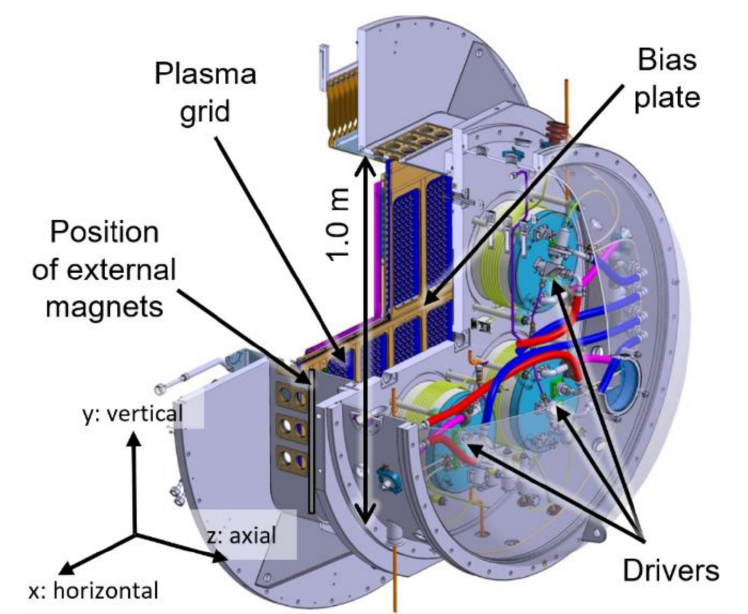
Figure 1. Schematic view of the ELISE ion source with three of the four RF drivers, the bias plate and the plasma grid. Additionally, indicated for one of the vertical sidewalls is the position of the respective row of external permanent